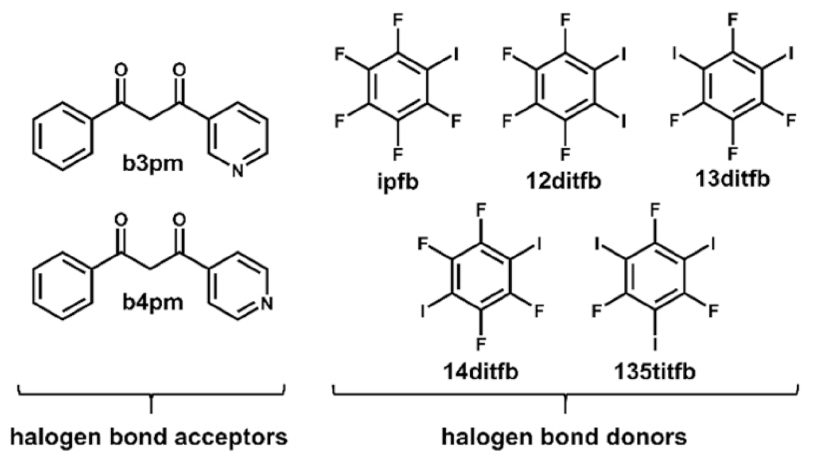
Figure 2. Halogen bond donors and acceptors used in